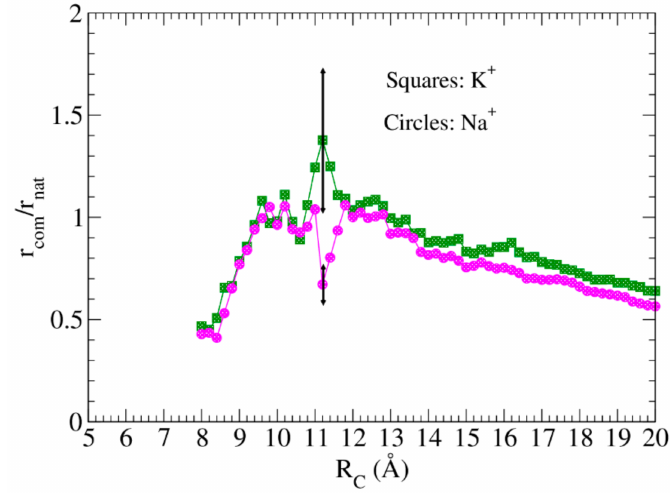
Figure 4. Resistance variation spectra of TBA in the presence of sodium and potassium. The resistance of the TBA-protein complex is larger than that of the TBA alone in a range of R C values close to 11 Å. In the whole range of R C values, the resistance ratio of the complex obtained in the presence of potassium is larger than those obtained in the presence of sodium.